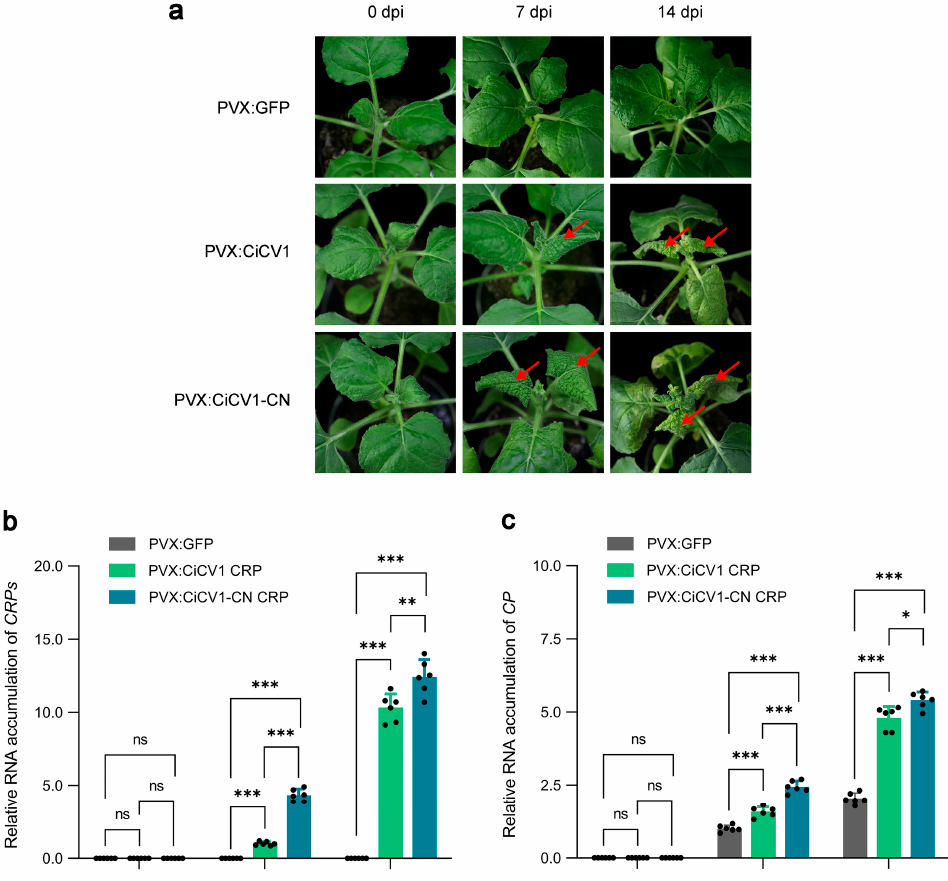
Figure 5. Cysteine-rich protein (CRP) encoded by the Chinese isolate of Carya illinoinensis carlavirus 1 (CiCV1-CN) is a pathogenicity factor of CiCV1-CN. ( a ) Roles of CiCV1 CRP and CiCV1-CN CRP in the modulation of symptom development in Nicotiana benthamiana . Wild-type N.